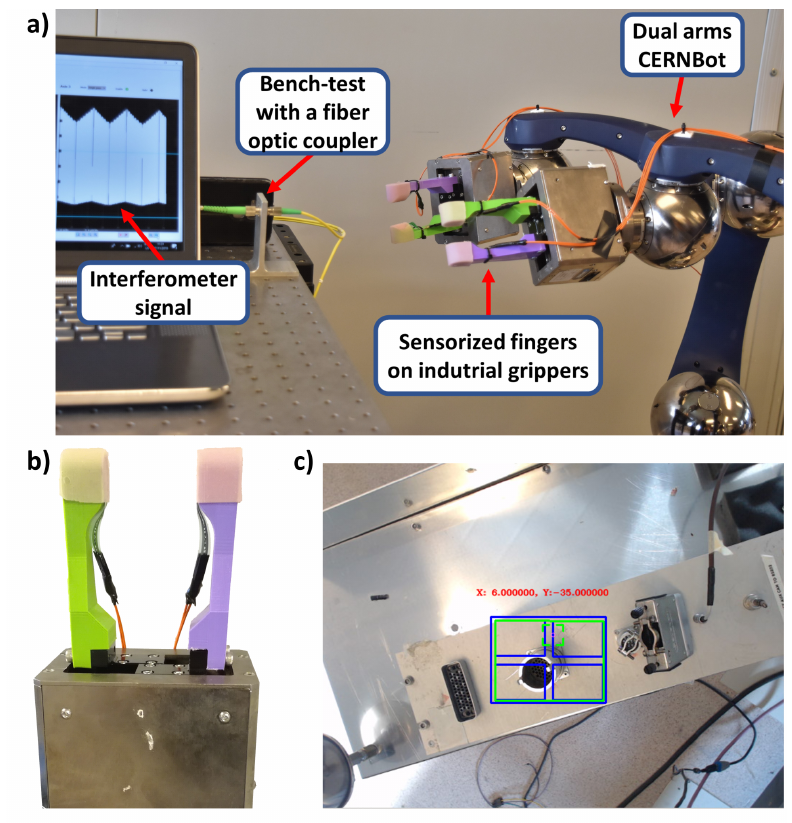
Figure 4. ( a ) Setup for experimental validation. ( b ) Particular of the gripper with the two ad hoc fingers. ( c ) Object recognition for the force reference of